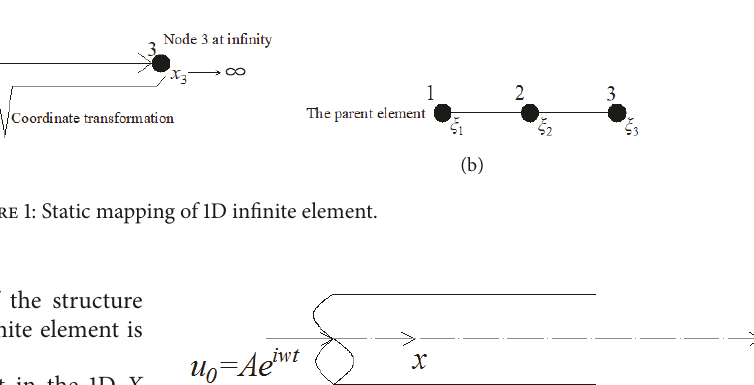
Figure 2: Semi-infinite elastic rod subjected to displacement distur-